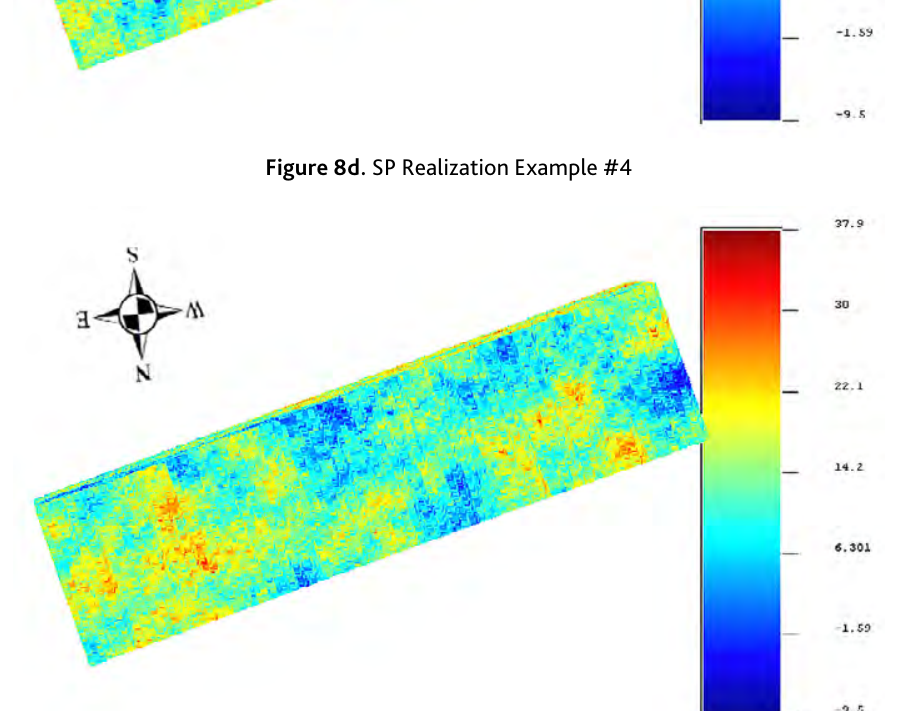
Figure 8d. SP Realization Example